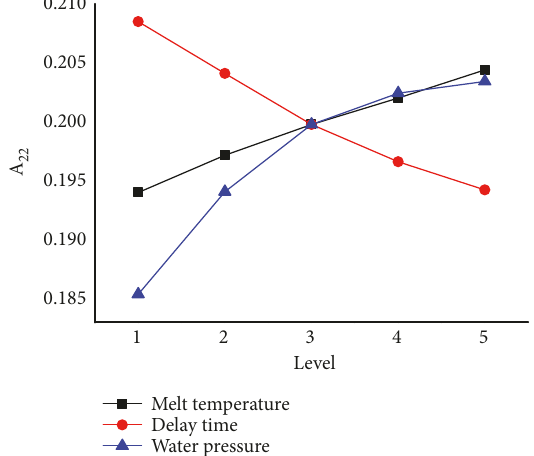
Figure13:InteractioneffectofdelaytimeandwaterpressureonA 22